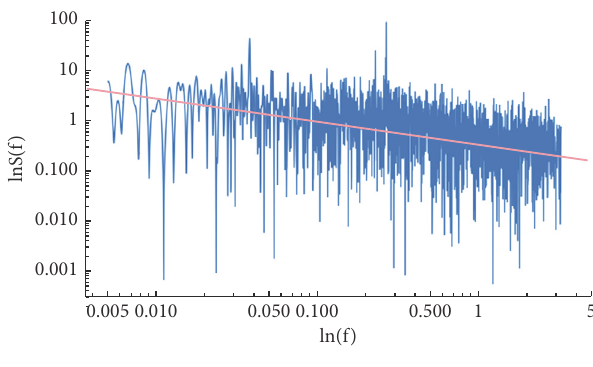
Figure 7: PSD for 𝜂 𝑡 time series.